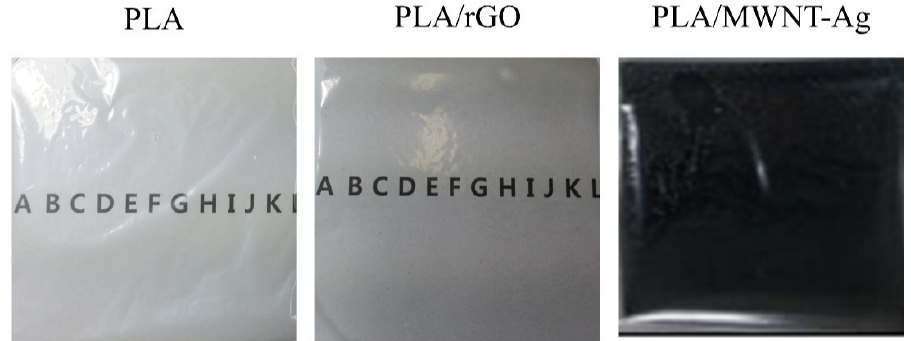
Figure 3. Transparency of PLA, PLA/rGO 1.0 wt%, and PLA/MWNT-Ag 1.0 wt% films.